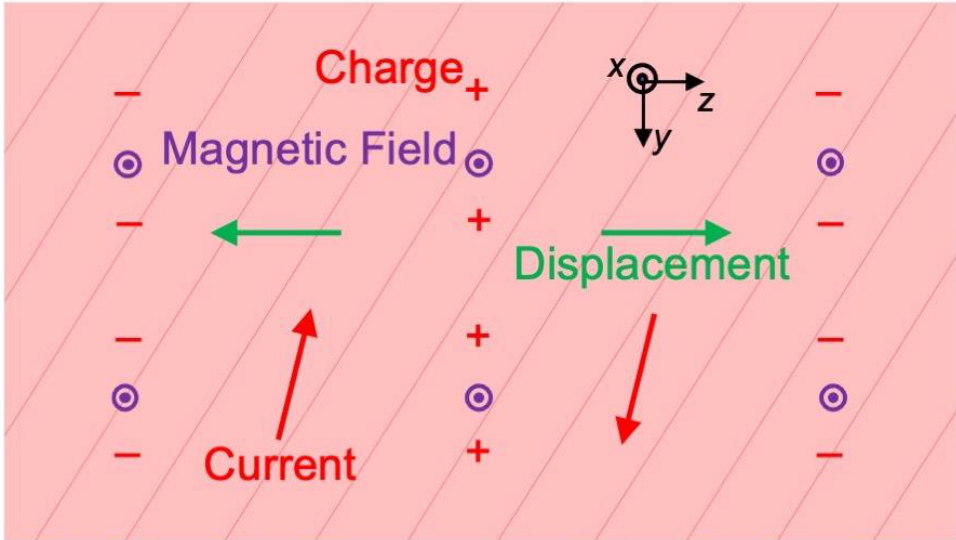
Figure 7. The current induced in anisotropic tissue when an ultrasonic wave propagates in a magnetic field. Because of anisotropy, the current density has a component in the z direction, causing the accumulation of positive and negative charge. One wavelength of the ultrasonic wave is shown and the fiber direction is indicated by the light lines at an angle of about 30° from the y -axis.